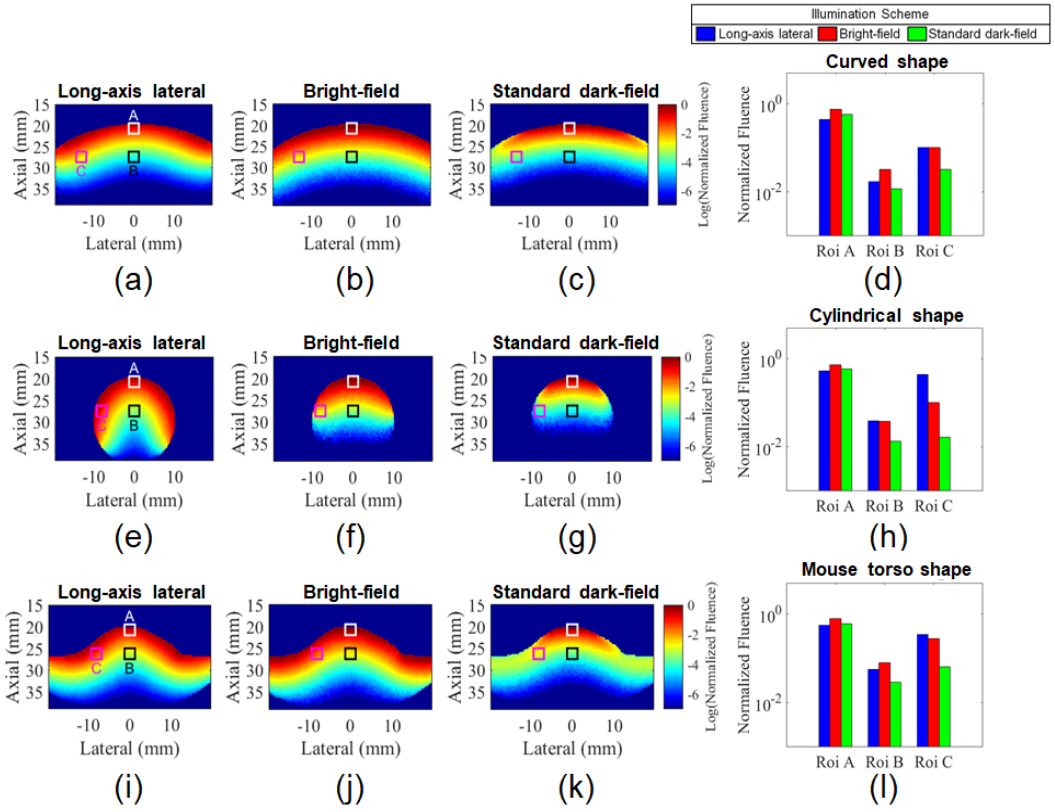
Figure 5. Normalized fluence maps obtained by Monte Carlo simulation for targets larger ( a – c ) and smaller ( e – g ) than the image width. An intermediate situation representing a mouse torso was also considered ( i – k ). All cases were simulated for the bright-field, standard dark-field, and long-axis lateral illumination schemes. Average fluence values were estimated within regions of interest (ROIs) A, B, and C for all cases ( d , h , and I ).